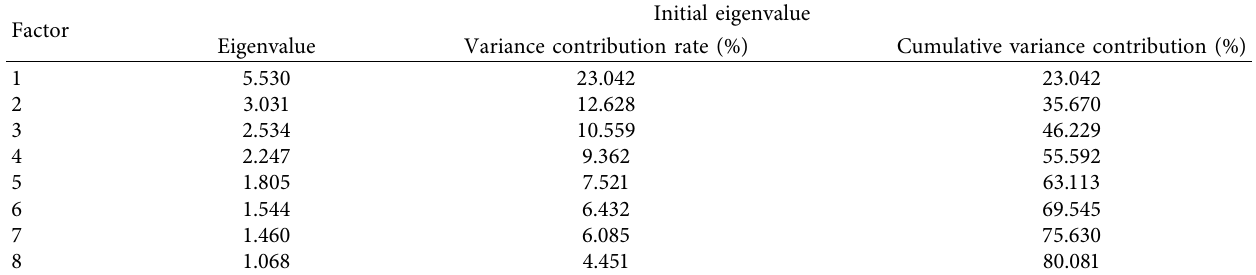
Table 17: Total variance of factor analysis.